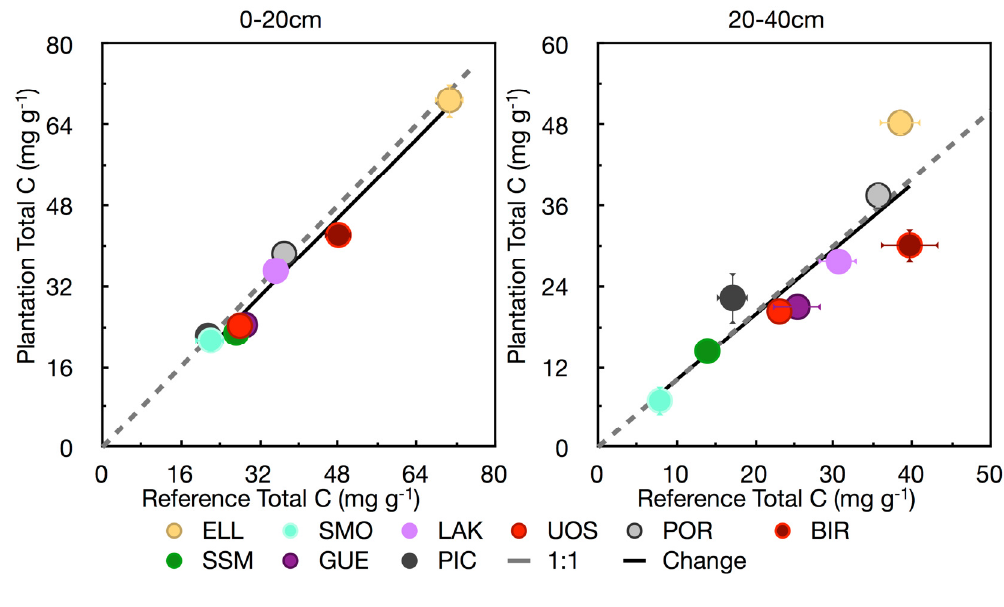
Figure 1. Initial concentration of total soil C, as estimated from reference sites, versus total soil C concentration in plantations after the first rotation of nine S. purpurea “Hotel” plantations (ELL, SMO, LAK, UOS, POR, BIR, SSM, GUE, and PIC). Error bars represent standard error when greater than symbol